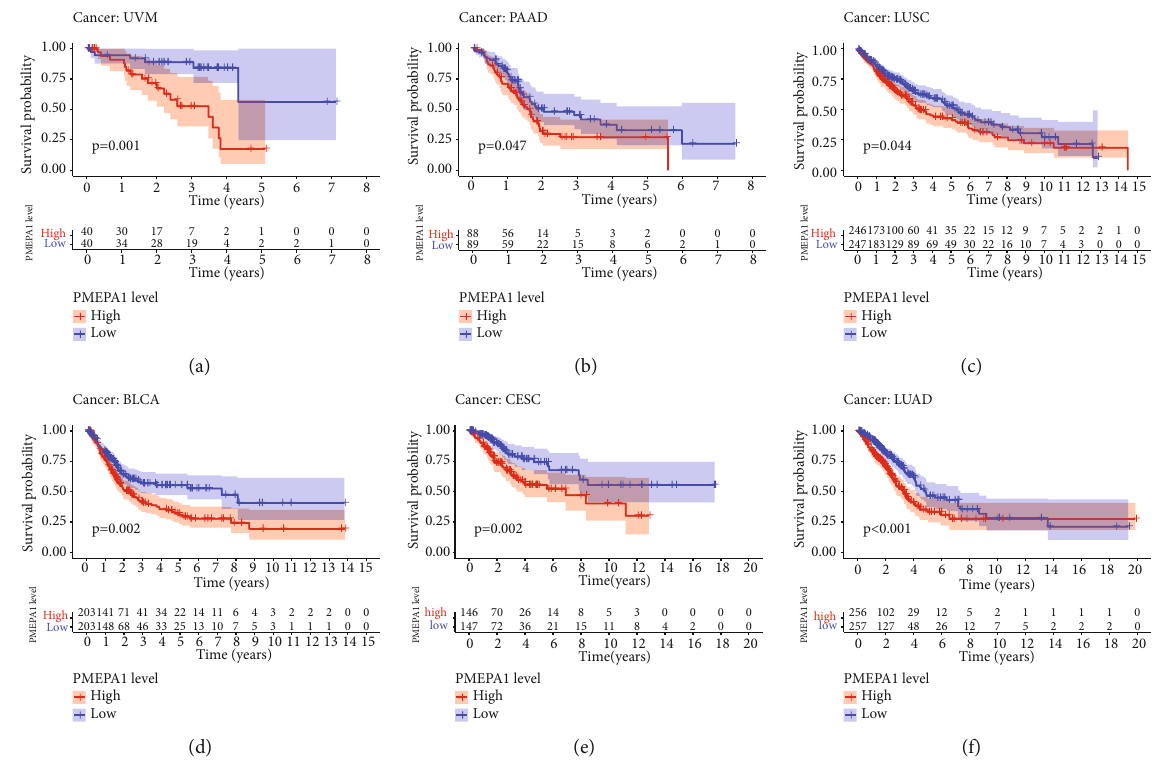
Figure 9: (a) – (f) K-M survival curves for PMEPA1 in pan-cancer ( P < 0 : 05